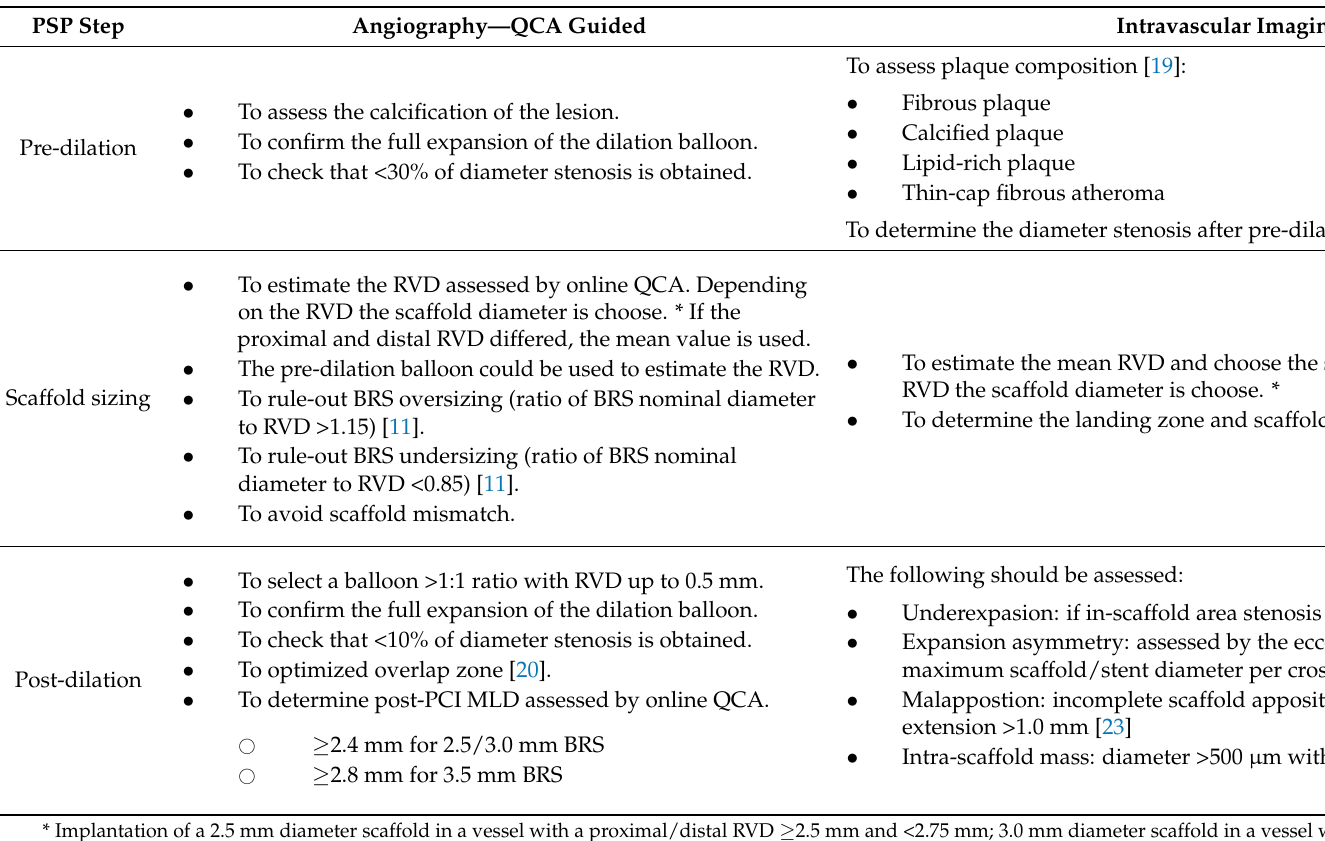
Table 1. Comparison of angiography—QCA and intravascular imaging-guided PSP